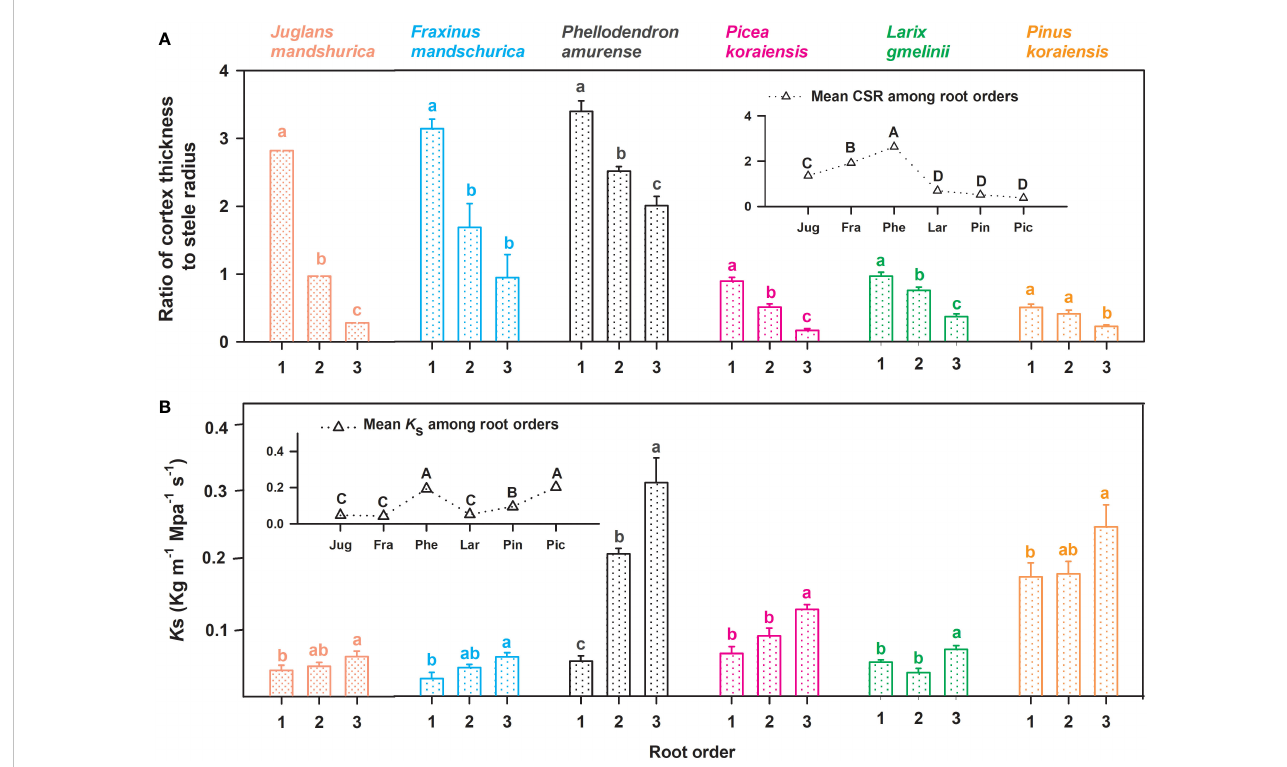
FIGURE 3 Ratio of unilateral cortex thickness to stele radius (CSR, (A) and the speci fi c conductivity ( K s , (B) for the fi rst three absorptive root orders in three angiosperms and three gymnosperms tree species ( n = 30). For each trait, in the subplots the mean value was calculated among root orders at the intraspeci fi c level. Different lower and upper case letters indicate signi fi cant differences ( p < 0.05) among root orders within each species and among six species,